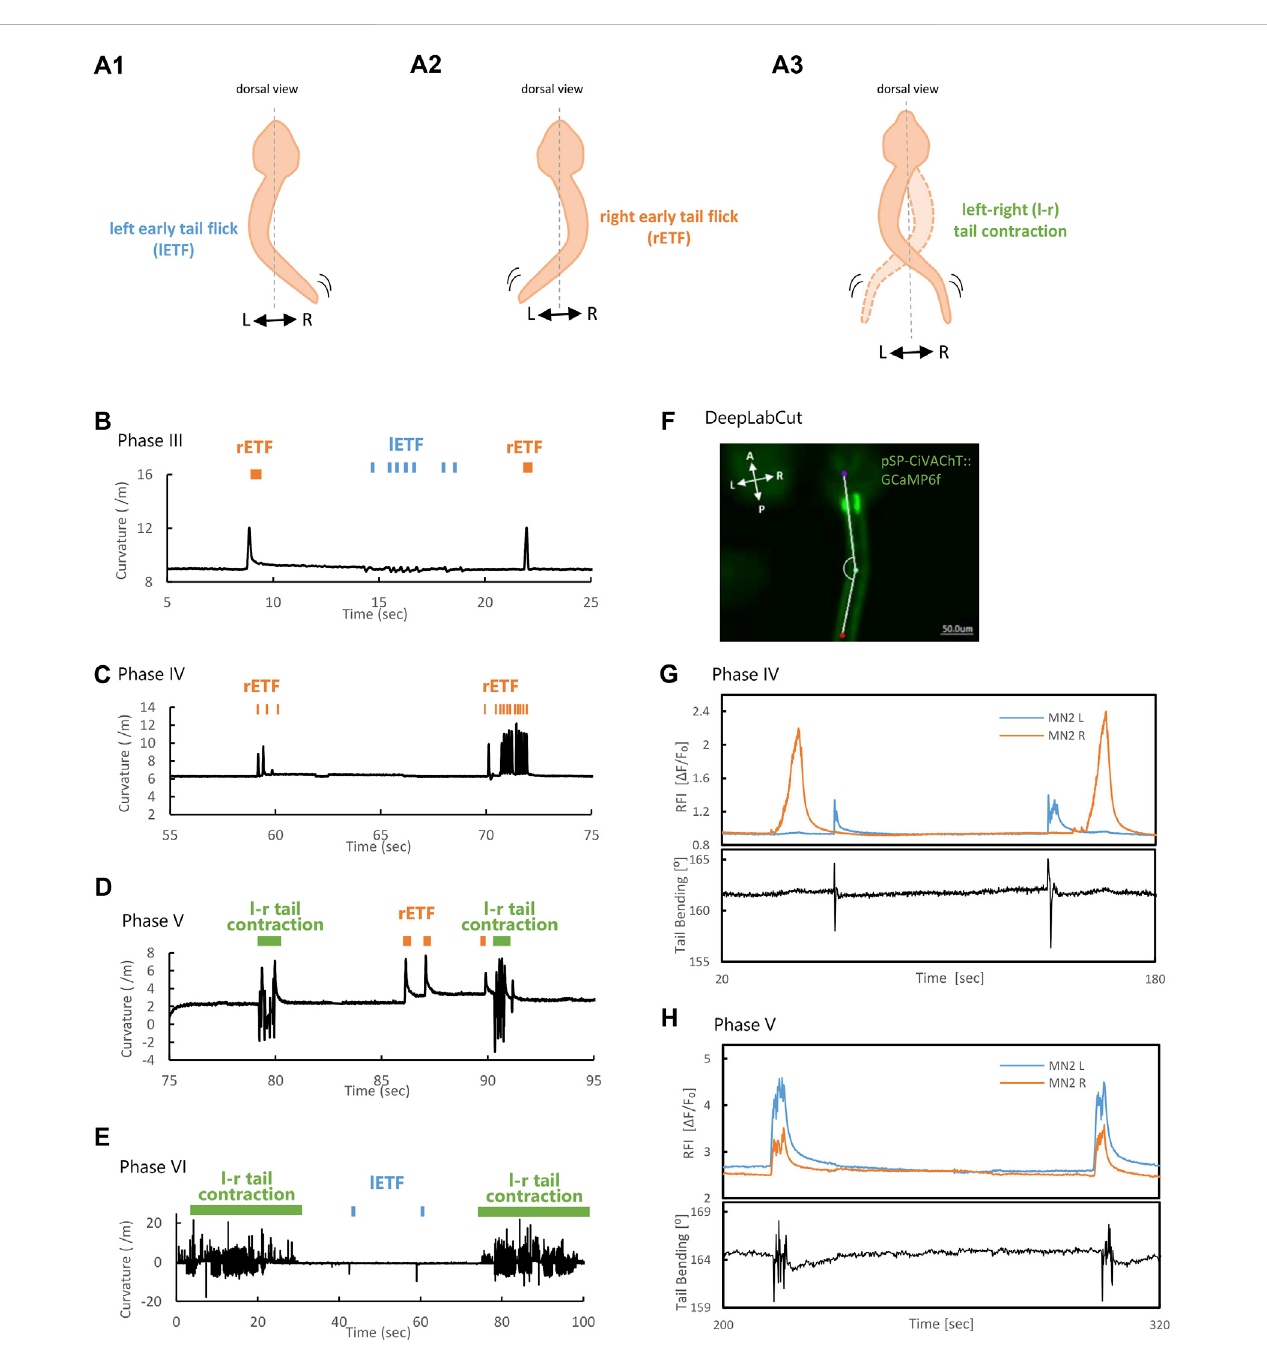
FIGURE 5 MN2L and MN2R Ca 2+ transients and tail movement from Phase III to Phase VI. (A) Schematic illustration of left Early Tail Flick (lETF), right Early Tail Flick (rETF), and left-right (l-r) tail muscle contraction. (B – D) Tail curvature observed in each phase. Orange bar indicates right-sided Early Tail Flick, blue bar indicatesleft-sidedEarlyTailFlick,andgreenbarindicatescontinuousleft-rightalternatetailcontraction(=swimmingbehavior).Longitudinalaxisiscurvature (/m);horizontalaxisistime(sec).Time=0(sec)representsthetimingwhenimagingstarted.Tailmovementbecomesfasterinthelaterphases. (B) Phase Ⅲ . (C) Phase IV. (D) Phase V. (E) Phase Ⅴ I. (F) Image with three body parts ( “ bodypart1 ” , purple, ocellus; “ bodypart2 ” , green, middle of the tail; “ bodypart3 ” , red, terminalofthetail)trackedautomaticallywithDeepLabCut.Theoriginalvideowastakenbya3CCDcamera(500msec/frame).Whitelinesareskeletons(aline connecting the three tracked body parts). (G – H) Tail bending and MN2 Ca 2+ transients. Longitudinal axis is Relative Fluorescent Intensity ( Δ F/F ₀ ), and tail bending ( ° ); horizontal axis is time (sec). Tail bending quanti fi ed with DeepLabCut. Time = 0 (sec) represents the timing when imaging started. (G) Phase